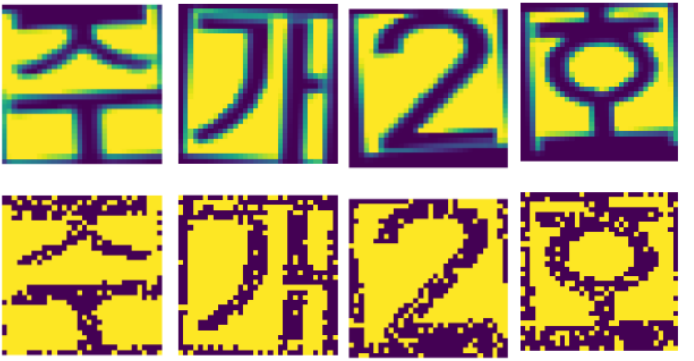
Figure 5. Images from the License plate dataset are converted into spikes using Poisson distribution. The upper images show original images, and the below images represent the spike version of original images.